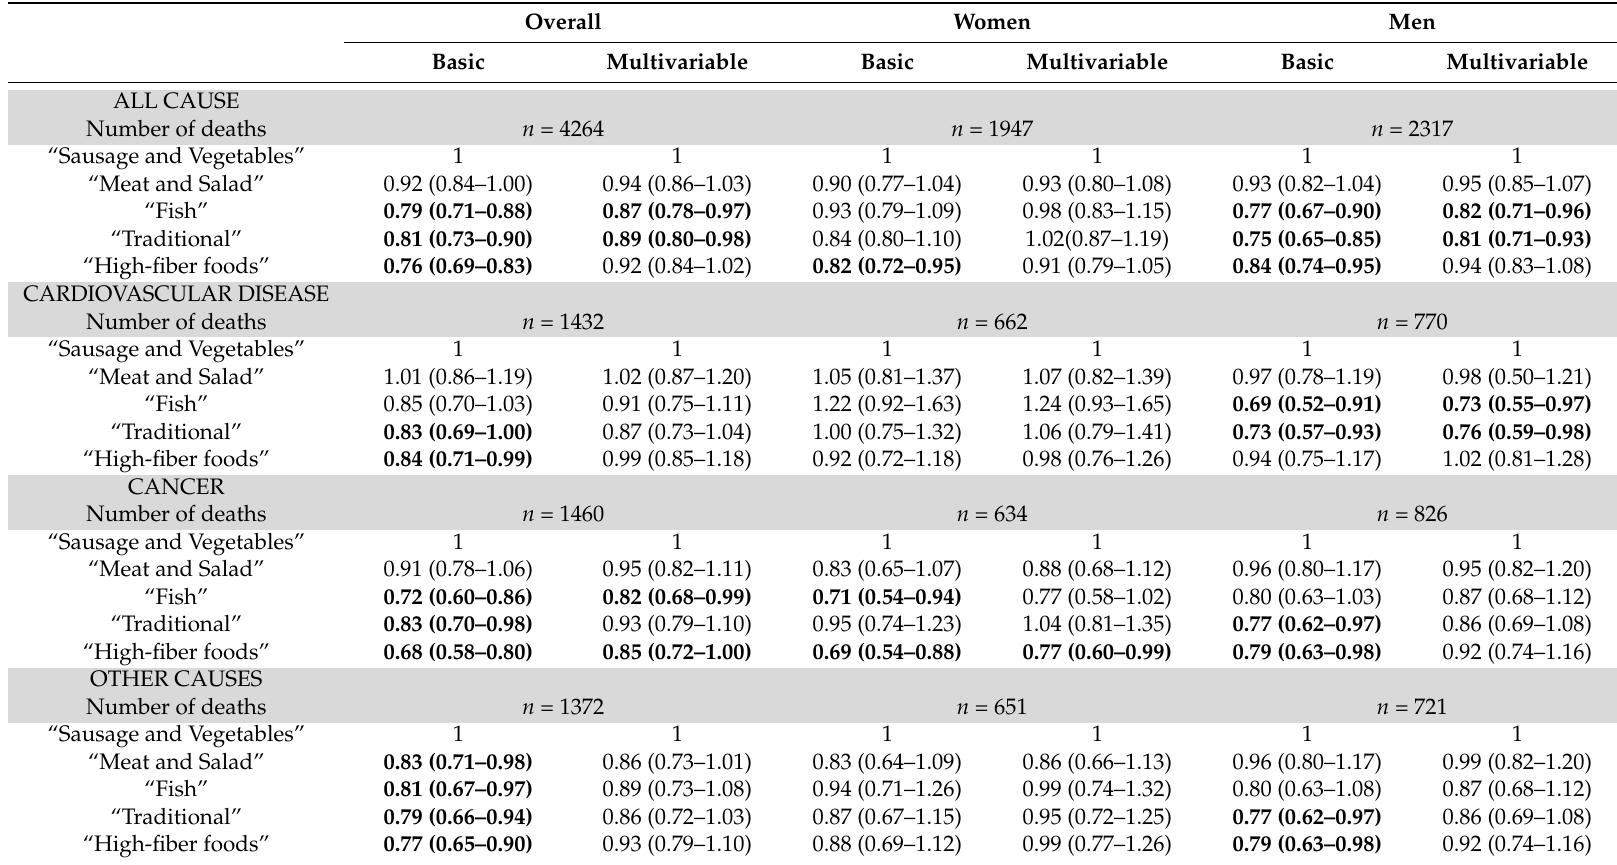
Table 2. Association between dietary patterns and all-cause or disease-specific mortality 1